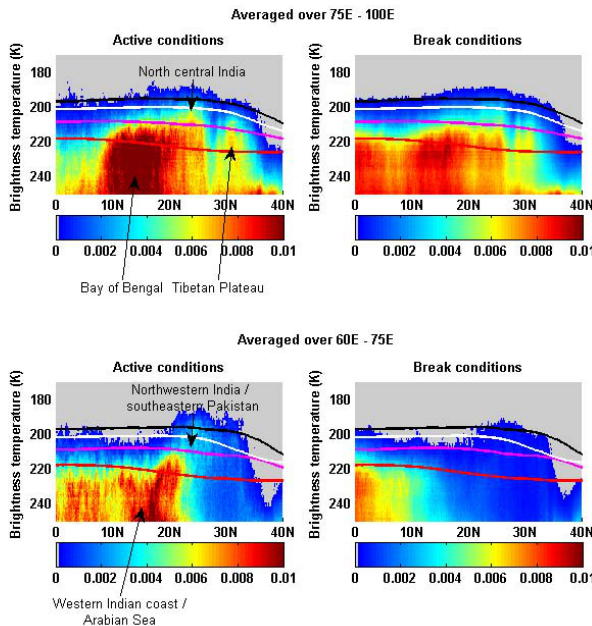
Fig. 5. The distribution (bin sizes of 0.1 degrees latitude by 1K brightness temperature; each latitude bin is normalized by the total number of observations (cloudy+clear) at all longitudes as indicated in the figure) of high opaque clouds during active and break mon- soon conditions for the eastern and the western parts of the study area (shown in Fig. 1 above). The black, magenta, and red lines are the mean temperatures at 100hPa, 150hPa and 200hPa derived from AIRS, while white line is the typical level of zero radiative heating from ERA-Interim (averaged June–September